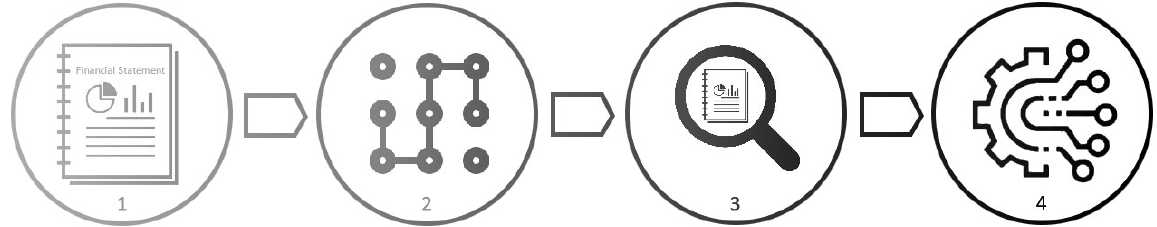
Figure 3. Discourse-analytical text mining process for feature engineering.